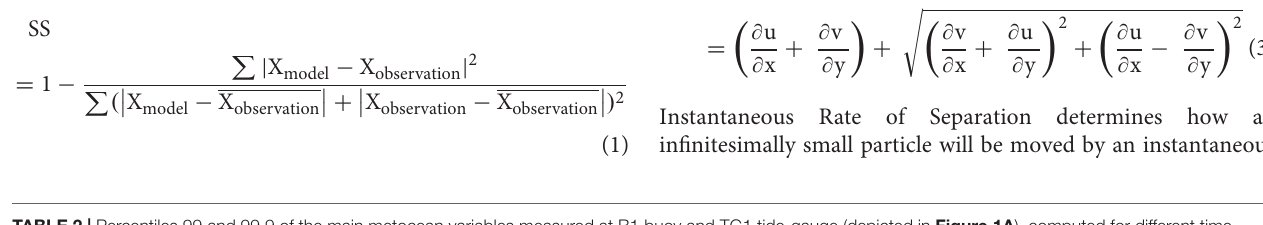
TABLE 2 | Percentiles 99 and 99.9 of the main metocean variables measured at B1 buoy and TG1 tide-gauge (depicted in Figure 1A ), computed for different time periods depending upon data availability. Parameter